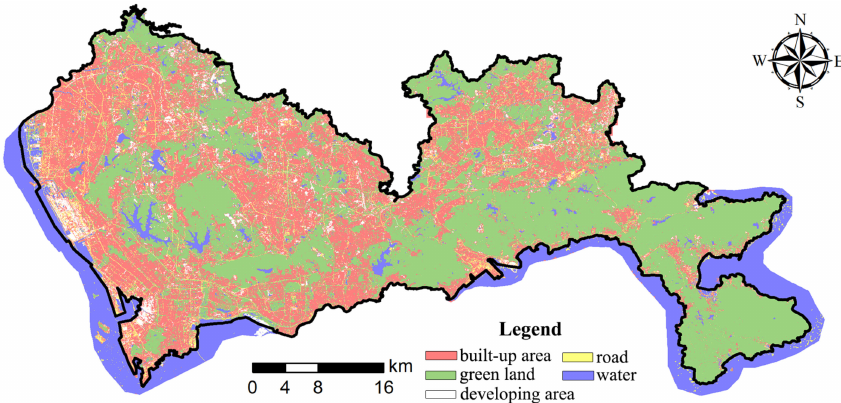
Figure 5. Land cover from SPOT-5